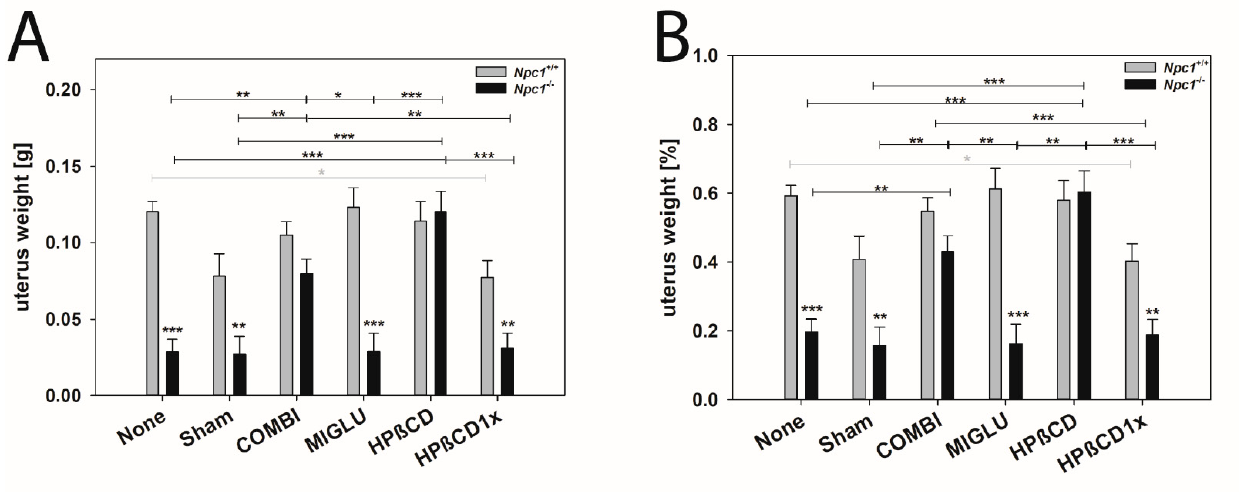
Figure 12. Uterus weight ( A ) and relative uterus weight ( B ) of Npc1 mice. Significant post-hoc tests are indicated by asterisks (* p < 0.05, ** p < 0.01, *** p < 0.001). Data are means ± SEM.